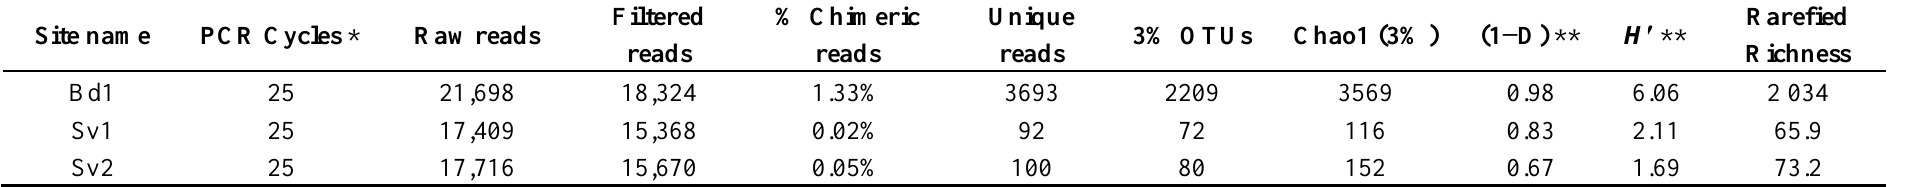
Table A1. Overview of sequence datasets.